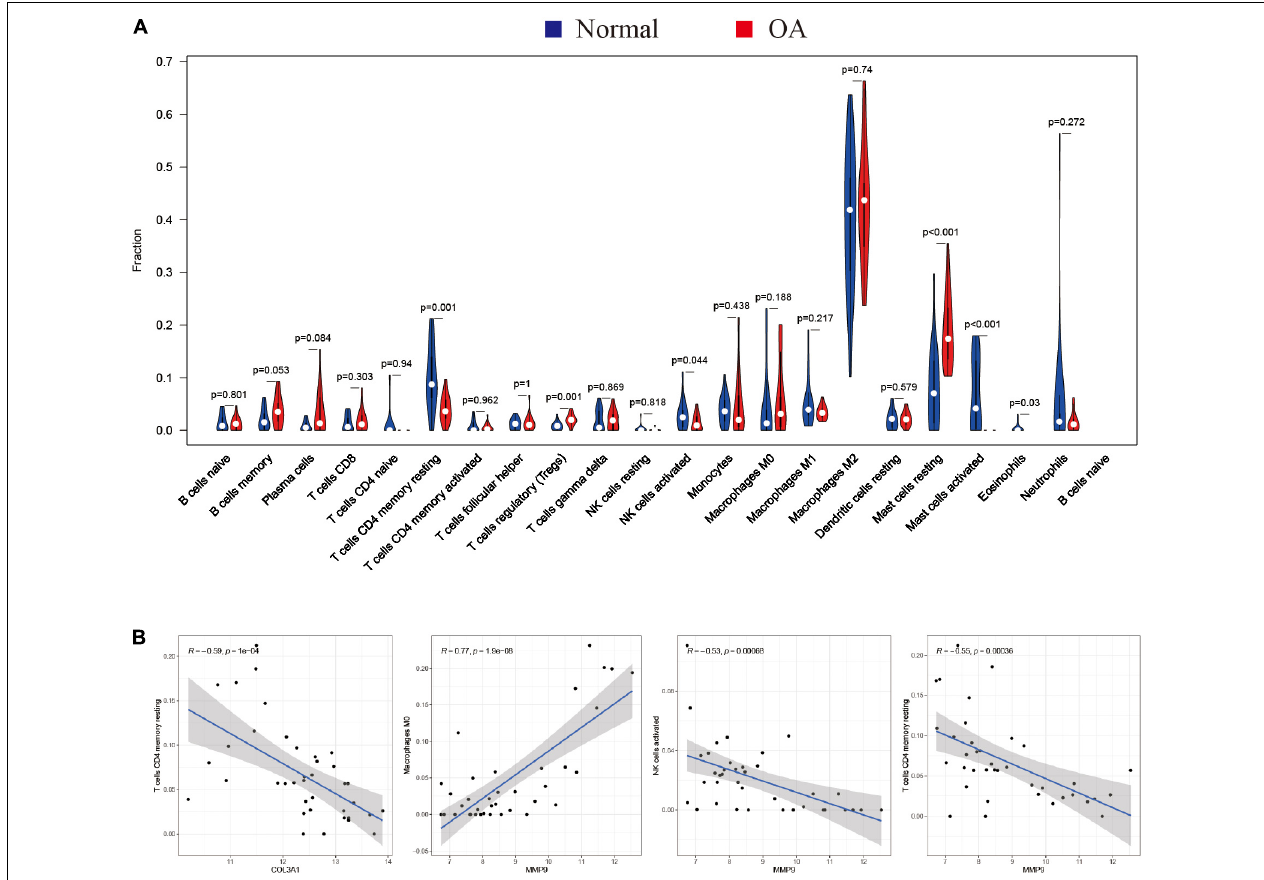
FIGURE 5 | Characterization of immune cell infiltration in normal and osteoarthritis (OA) samples and the correlation between hub gene expression and immune cell infiltration. (A) Violin plot showing the differentially infiltrated immune cells of a proportion of the 22 immune cell types. The red underline shows significant difference in the immune cell infiltration between the normal and rheumatoid arthritis (RA) groups. A value of p < 0.05 was considered to be statistically significant. (B) Correlation coefficient ( R ) > 0.5; p < 0.05 was considered statistically